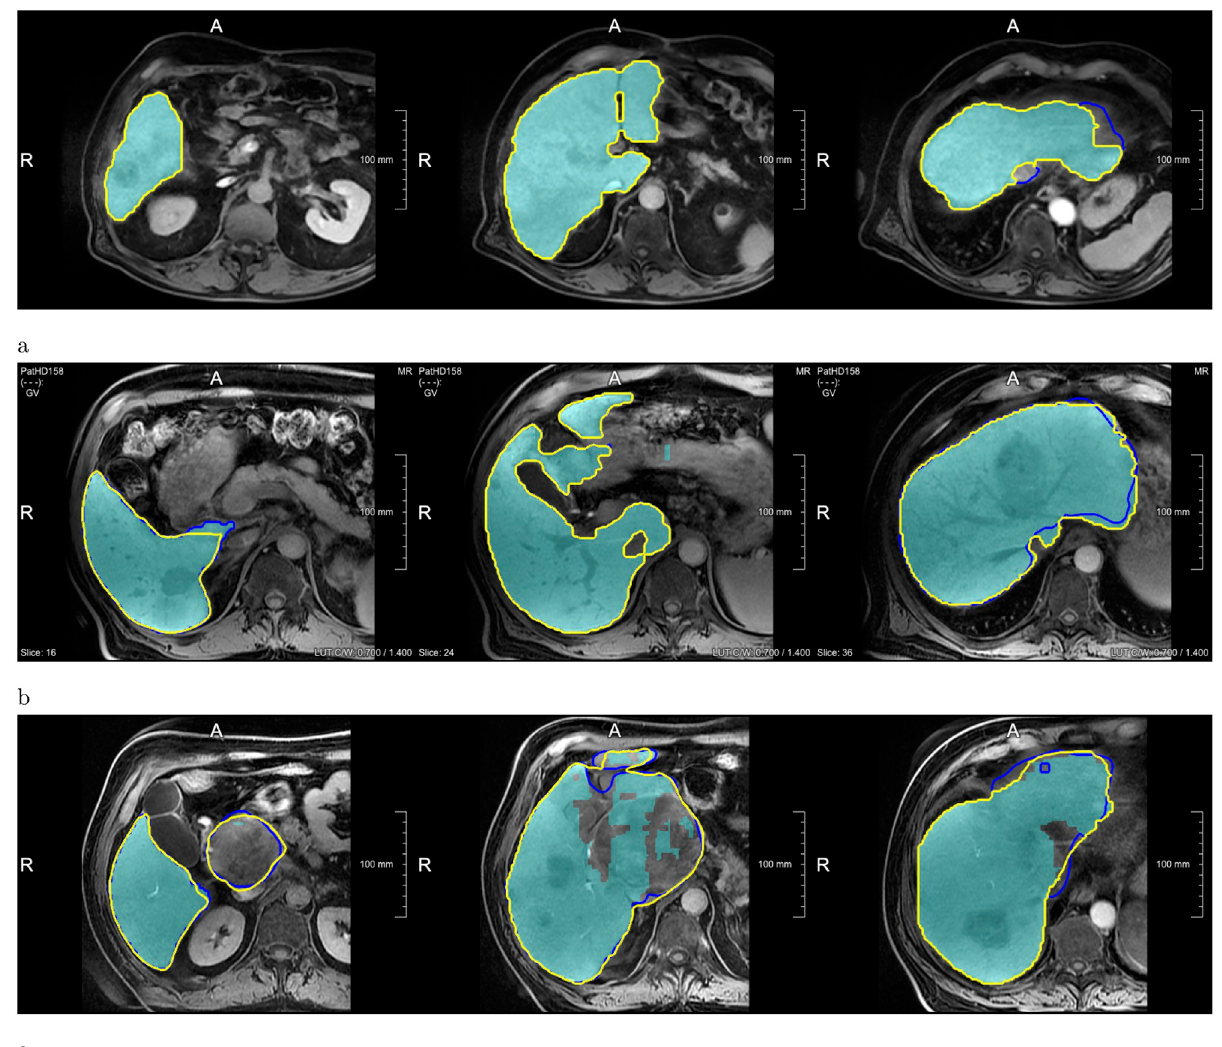
Fig 6. Examples showing how the automatic Liver-Net results (cyan) were corrected. The contours denote corrected liver masks by Res3 (blue) and RA (yellow). (a) Case with minor or no corrections: 1.42% for the Liver-Net liver masks, 1.51% (4.3%) and 1.42% (0%) RVE (CS) for the corrections by Res3 and RA, respectively. (b) Case where less than half of all slices were corrected: 5.66%, 5.57% (47.6%) and 5.40% (35.7%). (c) Case where most of the slices were corrected by all observers: 11.48%, 1.62% (74.0%) and 0.10%